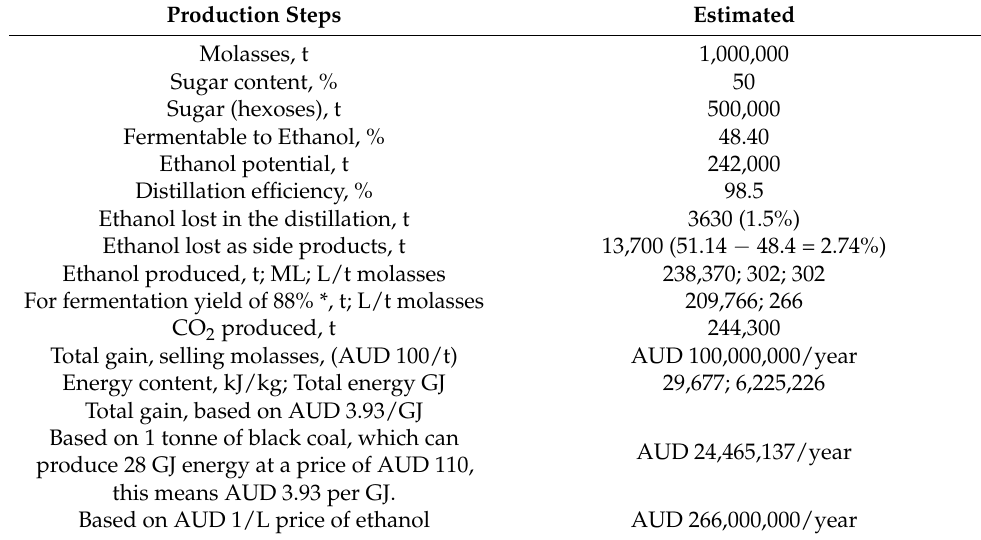
Table 9. Potential of ethanol production form final molasses in